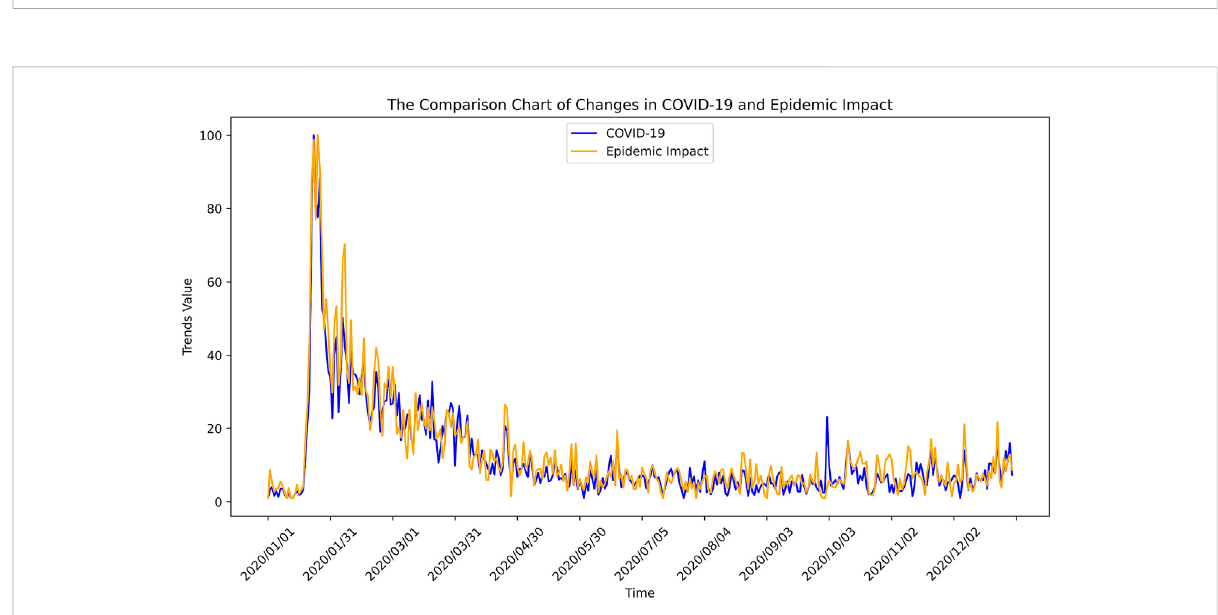
FIGURE 7 The comparison chart of changes in the attention of COVID-19 and epidemic